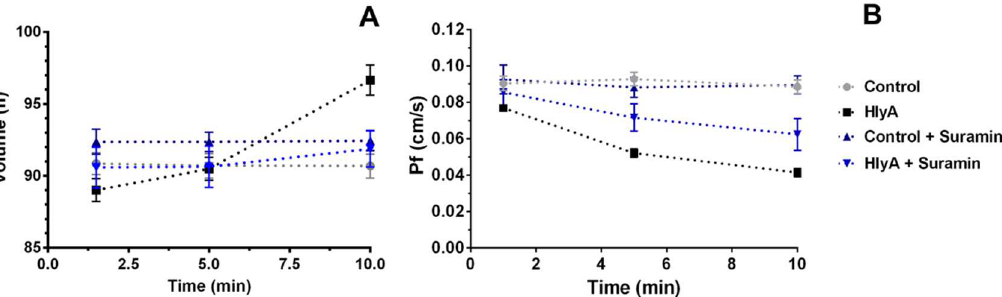
Figure 3. Effects of Suramin on MCV and P f changes induced by HlyA. RBCs suspensions at 10% hematocrit were used to determine MCV ( A ) and P f ( B ) after 1, 5 and 10 min of HlyA treatment (100 ng/mL). P f values were calculated, as indicated in Section 4.8, from stopped-flow experiments. Before HlyA addition, cells were pre-incubated in the absence or presence of suramin 100 µM for 10 min at 37 °C. Control experiments were run in the absence of toxin. Points in the plots represent means ± S.E.M. In ( A ) Control, N = 20; Control+Suramin and HlyA+Suramin, N = 5; HlyA, N = 15. In ( B ) Control, N = 18; Control+Suramin and HlyA+Suramin, N = 4; HlyA, N = 15.